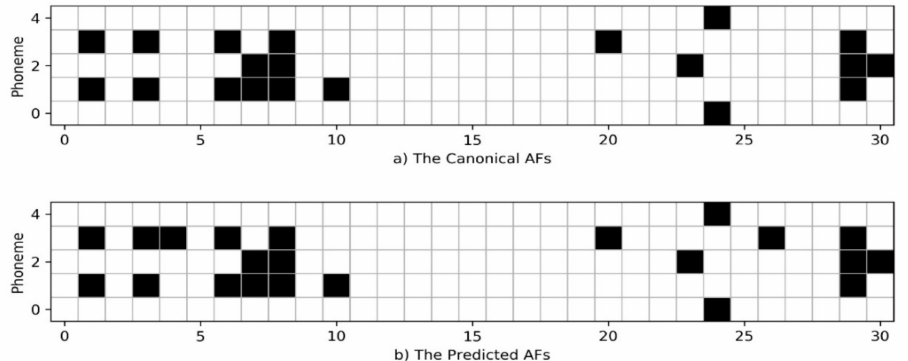
Figure 9. Visualization of the AFs in the test file “CYDSSFA” from KAPD corpus. ( a ) The canonical AFs. ( b ) the predicted